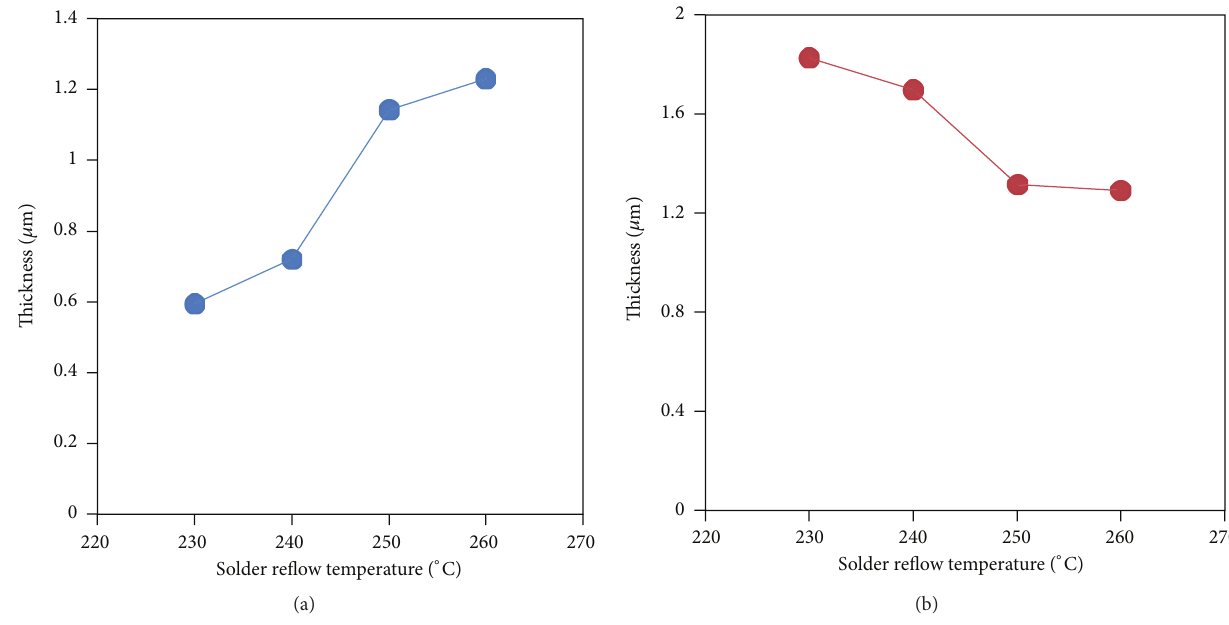
Figure 12: (a) Cu 3 Sn and (b) Cu 6 Sn 5 IMCs thickness as a function of reflow temperature at a reflow time of 30s.